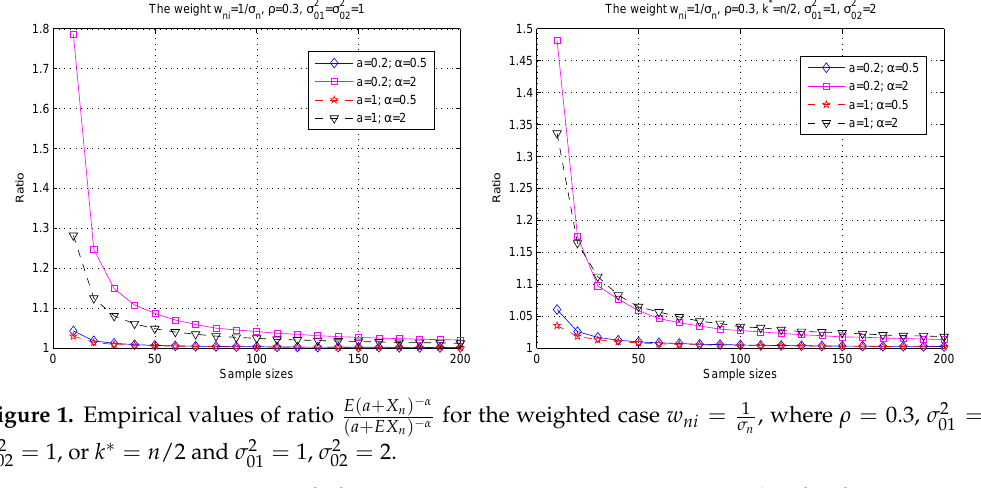
, where ρ = 0.3, σ 2 σ n